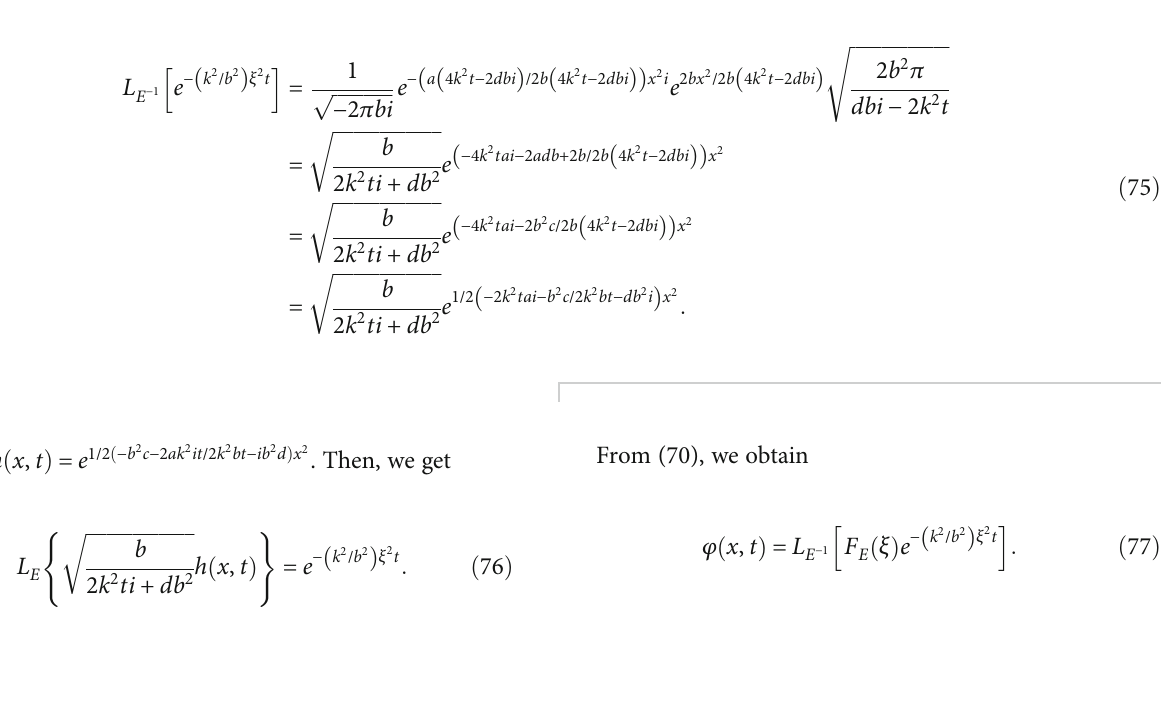
ffiffiffiffiffiffiffiffiffiffiffiffiffiffiffiffiffiffiffi